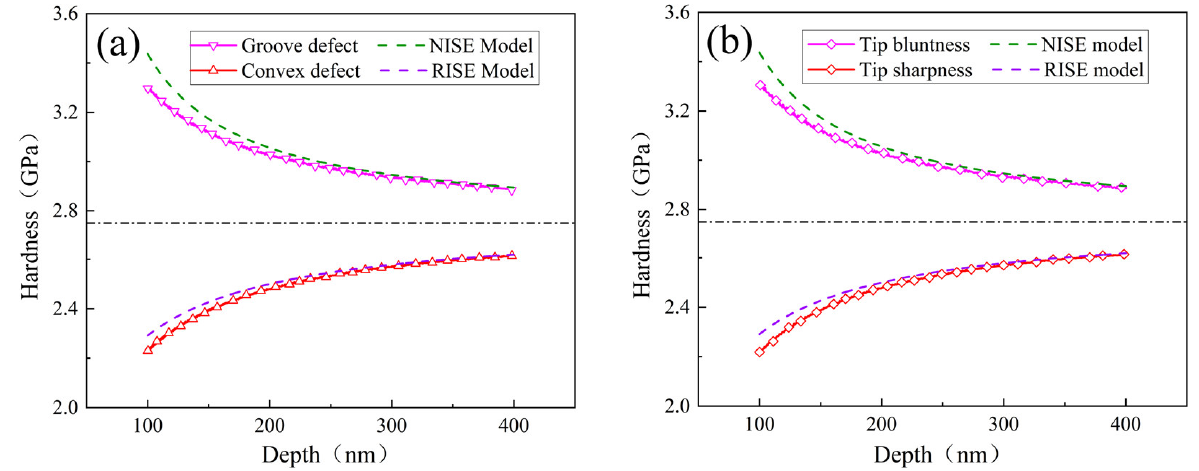
Figure 10. Comparison of theoretical predicted model and numerical simulation: ( a ) surface defect; ( b ) indenter tip irregularity.